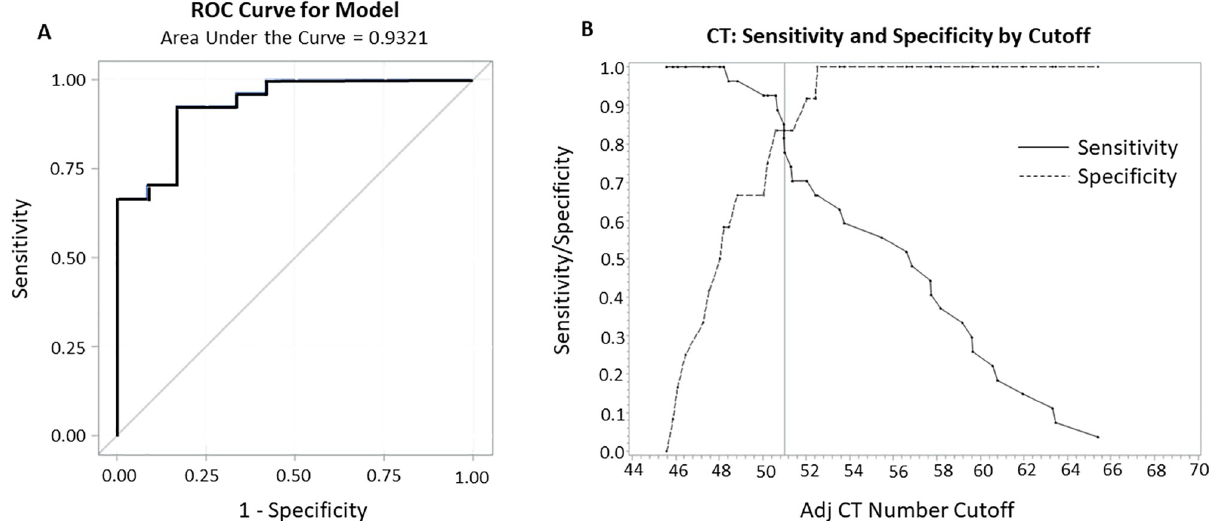
Fig 8. Receiver operating curve, sensitivity, and specificity for CT HU to indicate fibrosis. A) Receiver Operating Characteristic Curve. Showing an AUC of 0.93. B) Graph of Sensitivity and Specificity by cutoff.